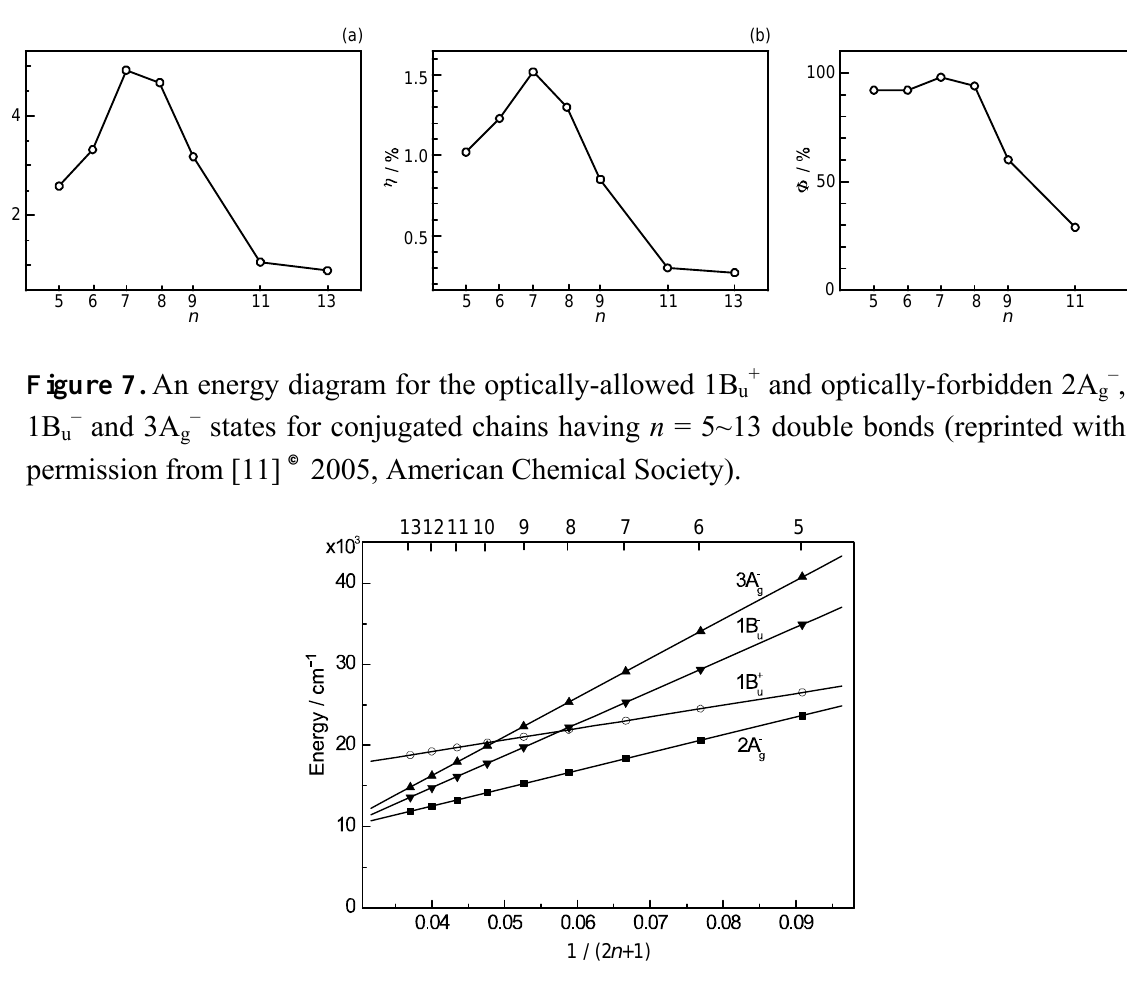
Figure 6. Conjugation-length ( n ) dependence of (a) the photocurrent ( J conversion efficiency ( η ) in solar cells using the RA and CA sensitizers, and (c) the electron-injection efficiency ( Φ ) in the RA and CA sensitizers bound to TiO nanoparticles in suspension (reprinted with permission from [11] © 2005, American Chemical Society).